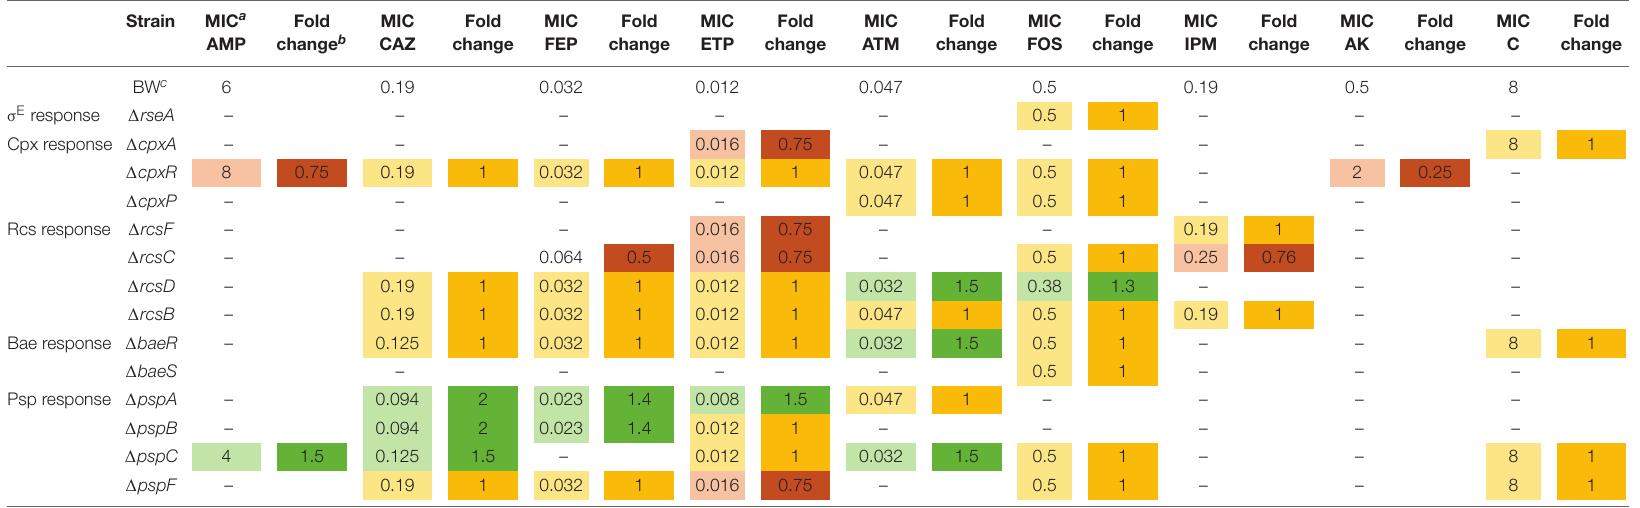
TABLE 1 | Susceptibility test determined by gradient strip